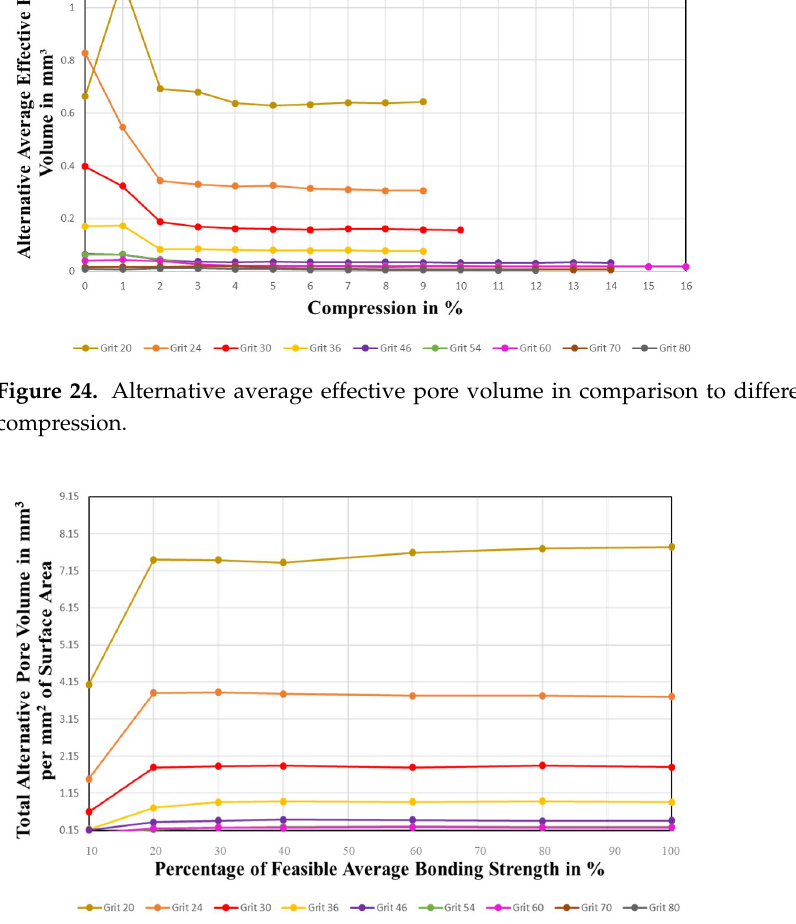
Figure 25. Alternative average effective pore volume in comparison to the percentage of maximum feasible average bonding